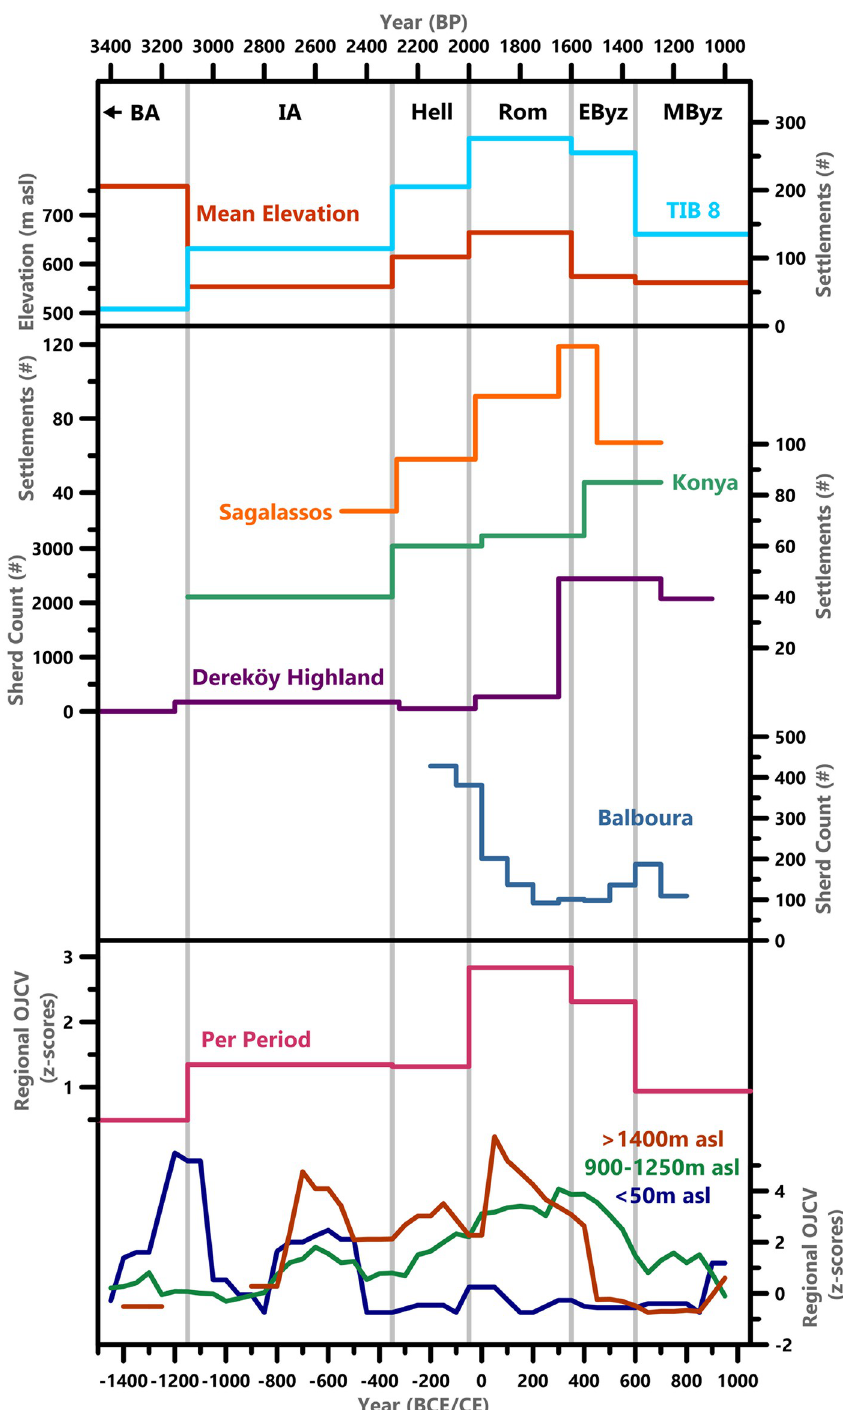
Fig 6. Regional survey data. TIB settlement data and mean elevation by period compared to other regional surveys and OJCV value z-scores—per period and as 200-year averages. References found in the main text.